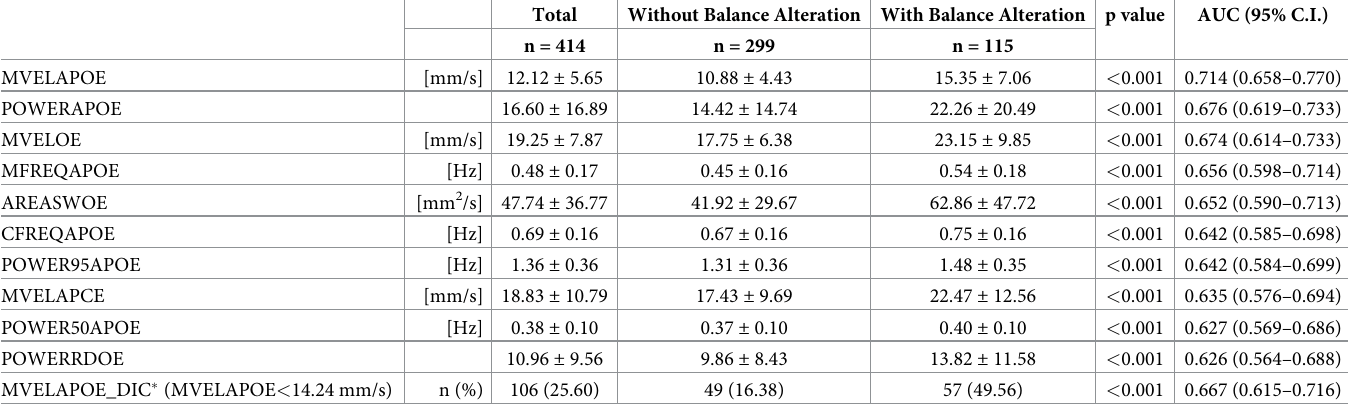
Table 2. Center of pressure (CoP) indexes with the highest area under the curve (AUC) related to balance alteration and descriptive analysis for the dichotomized mean velocity in the antero-posterior displacement with eyes open (MVELAPOE_DIC). Total Without Balance Alteration With Balance Alteration p